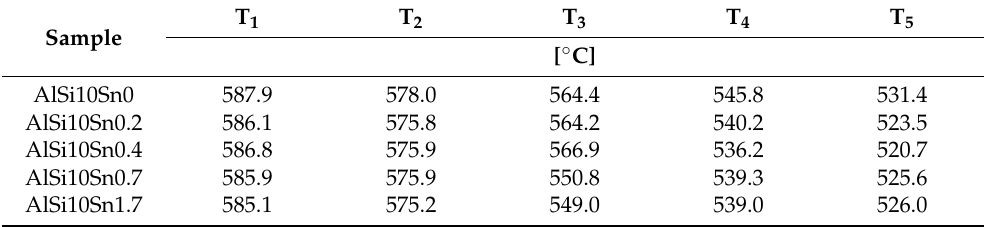
Figure 4. Characteristic temperatures of crystallisation were determined on the basis of TDA. T1—beginning of crystallisation (separation of primary α phase dendrites); T2—triple eutectic crystalli- sation ( α + Al 9 Fe 2 Si+ β ); T3—triple eutectic crystallisation ( α + Mg 2 Si + β ); T4—triple eutectic crystallisation ( α + Al 2 Cu + β ); T5—end of crystallisation.